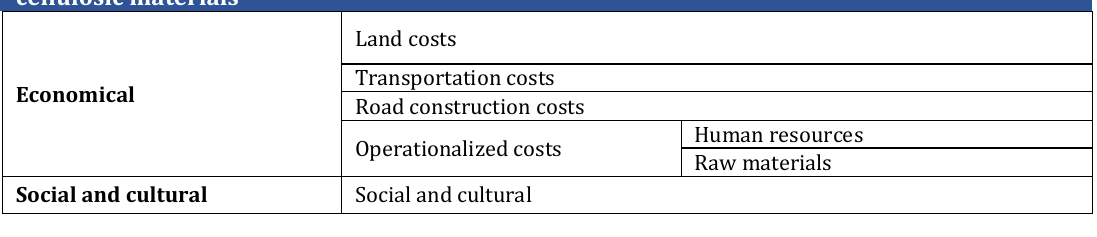
Table 5: The main criterion of the opportunities for site selection of new energies production from cellulosic materials